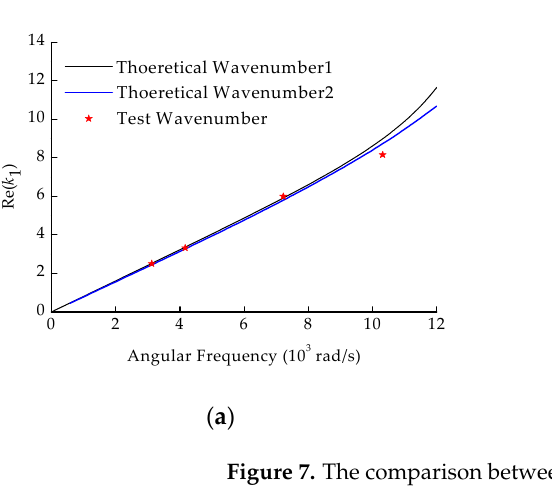
Figure 6. The variety of approximate functions with the identified soil parameters.